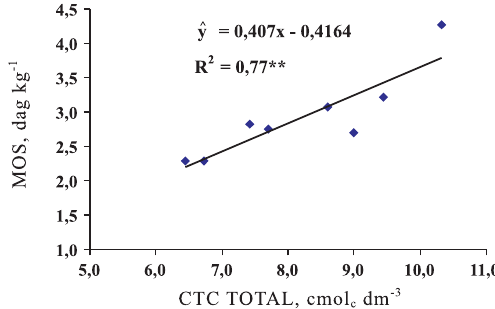
Figura 1. Correlação entre os teores de matéria orgânica do solo (MOS) e a capacidade de troca catiônica total (CTC total) para o Latossolo sob diferentes